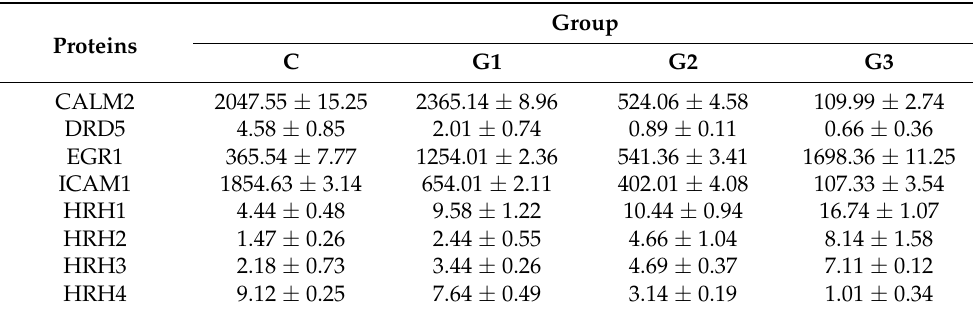
Table 2. Expression profile of biogenic amine-related proteins in serum in the study and in the control groups ( p < 0.05). Group Proteins C G1 G2 G3 CALM2 2047.55 ± 15.25 2365.14 ±